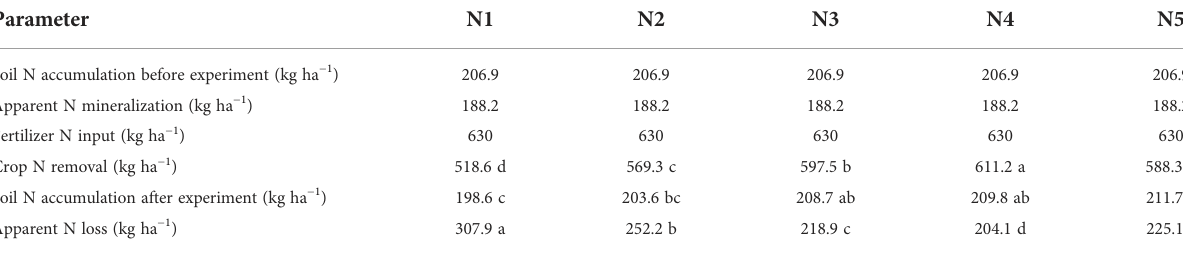
TABLE 3 Apparent nitrogen (N) budget for the 0 to 100 cm depth in the plant – soil system in different N treatments over three years (2018 to 2020).